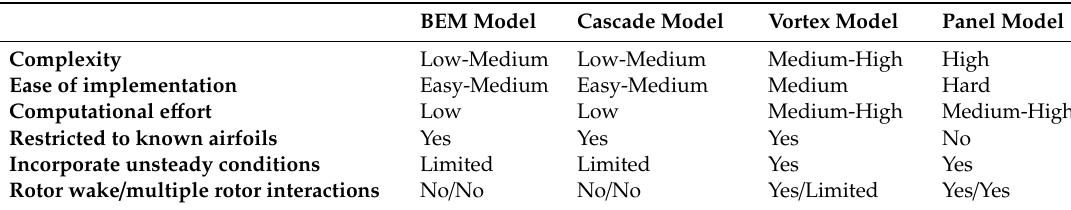
Table 1. Comparison of aerodynamic models [5].